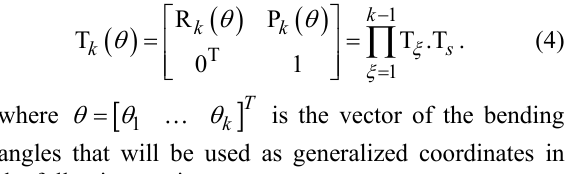
Figure 1. CDCR schematics